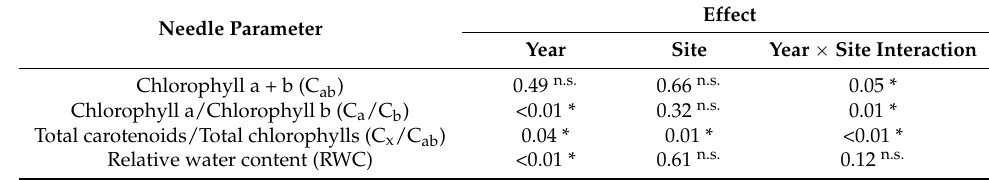
Table 5. Effect of year sampling, site and their interaction on content of photosynthetic pigments, their ratios and water content. Two-way ANOVA, n.s. = not significant, * significant with p <